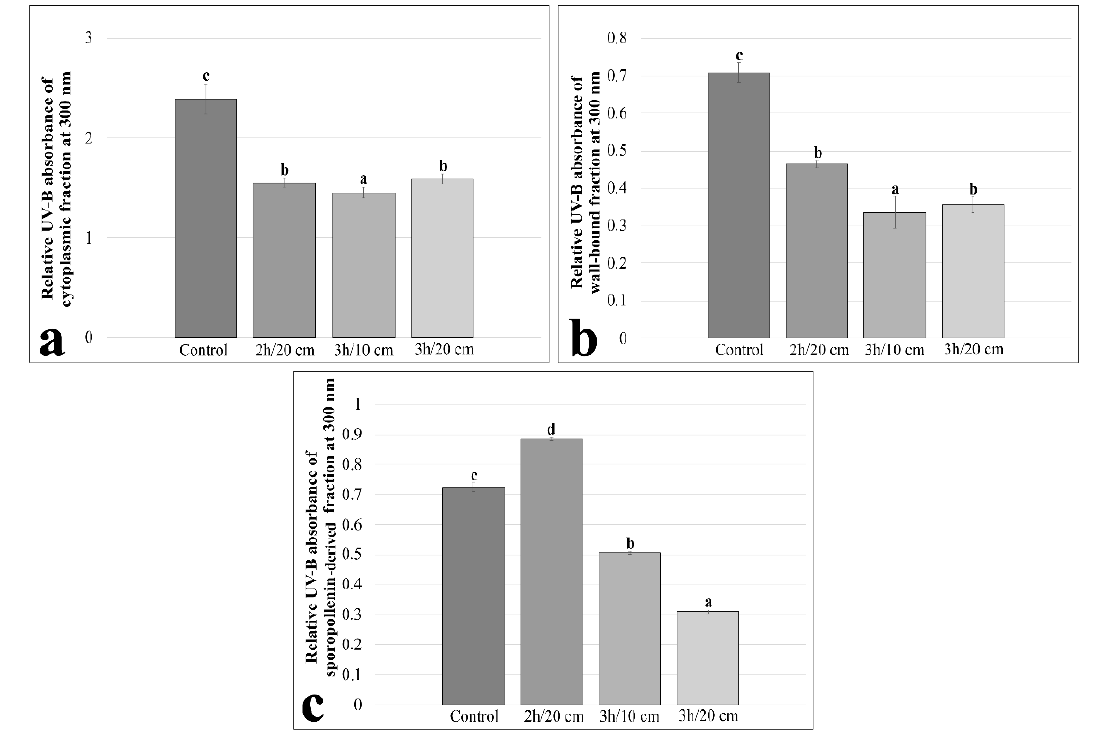
Figure 4. The effects of UV-B radiation on relative UV-B absorbance of different fractions on the groups showing more acute effects caused by exposure to UV-B rays. ( a ) UV-B absorbance of cytoplasmic fraction after 2 h of treatment at 20 cm, 3 h of treatment at 10 cm and 3 h of treatment at 20 cm; ( b ) UV-B absorbance of wall-bound fraction after 2 h of treatment at 20 cm, 3 h of treatment at 10 cm and 3 h of treatment at 20 cm; ( c ) UV-B absorbance of sporopollenin-derived fraction after 2 h of treatment at 20 cm, 3 h of treatment at 10 cm and 3 h of treatment at 20 cm. Different letters within the figures indicate statistically significant differences.